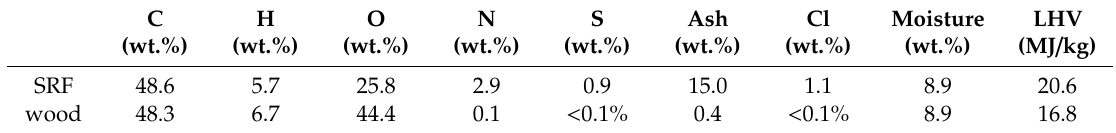
Table 1. Feedstock characteristics (dry basis).